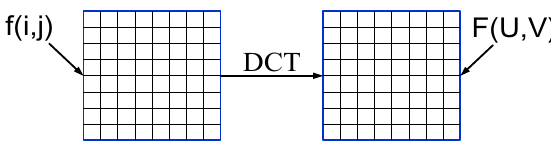
Fig. 3 Change the image matrix framework from the spatial domain to the frequency domain using